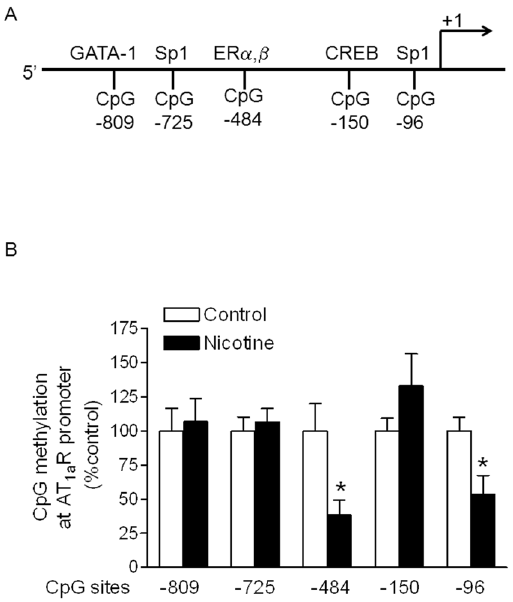
Figure 6. Effect of nicotine on CpG methylation of AT 2 R promoter in aortic rings in male offspring. Aortic rings were freshly isolated from male adult offspring that had been exposed in utero to saline control or nicotine. DNA was isolated and methylation levels were determined by methylation-specific real-time PCR. Data are means 6 SEM of tissues from saline control (n=4) and nicotine (n=4). The sample sizes represent the animal number from different litters of each group. Data were analyzed by student t -test. * P , 0.05 vs. control.